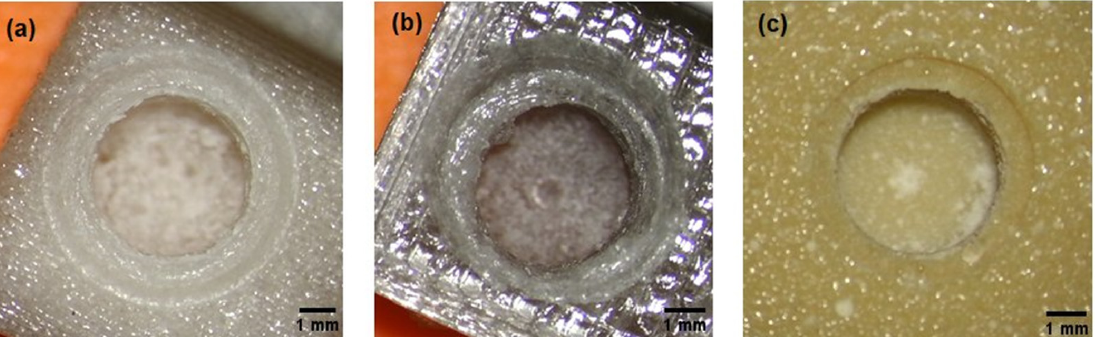
Figure 7. The effects of drilling with surgical drills; from the left, a model from: ( a ) the tested material, ( b ) the tested material after the drying process before its 3D printing, ( c ) a commercial material from Cochlear. X12.5 focal length 225–230 mm.